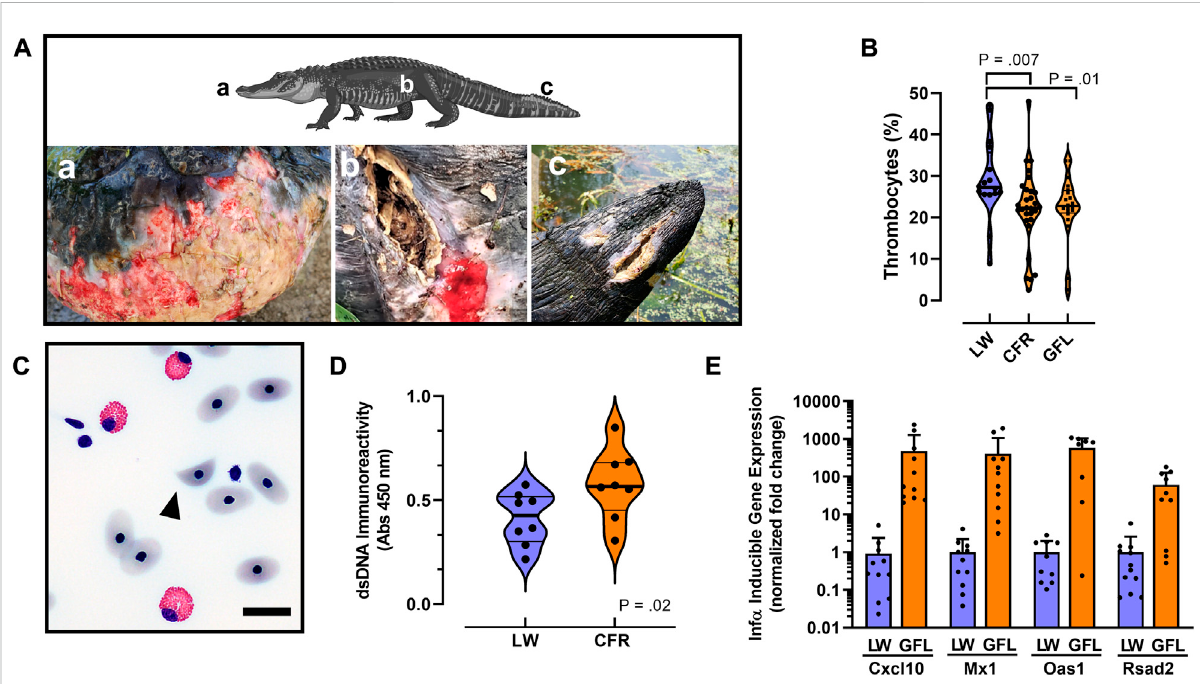
FIGURE 4 Autoimmune-like phenotypes associated with PFAS exposure. (A) Examples of cutaneous lesions and unhealed wounds associated with PFAS exposure in 3 representative animals sampled from the Green fi eld Lake in 2019. Lower case letters indicate body location of lesion shown in each panel. (B) Violin plots comparing median thrombocyte numbers quanti fi ed from whole blood smears in alligators from Lake Waccamaw ( n = 16), Cape Fear River ( n = 39) and the subset from Green fi eld Lake ( n = 20). (C) Representative photomicrograph of a schistocyte